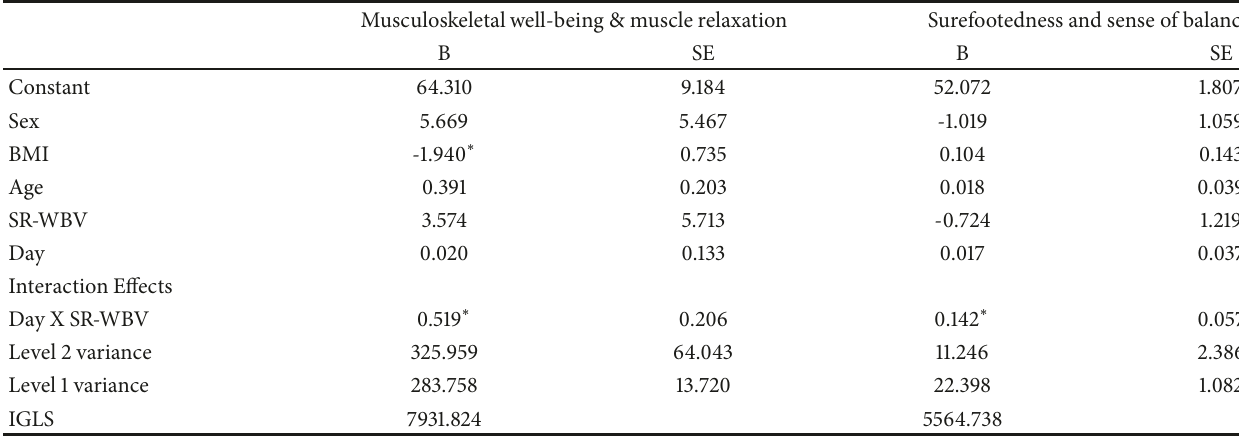
Table 3: Prediction of daily surefootedness, sense of balance, musculoskeletal well-being, and muscle relaxation in multilevel regression